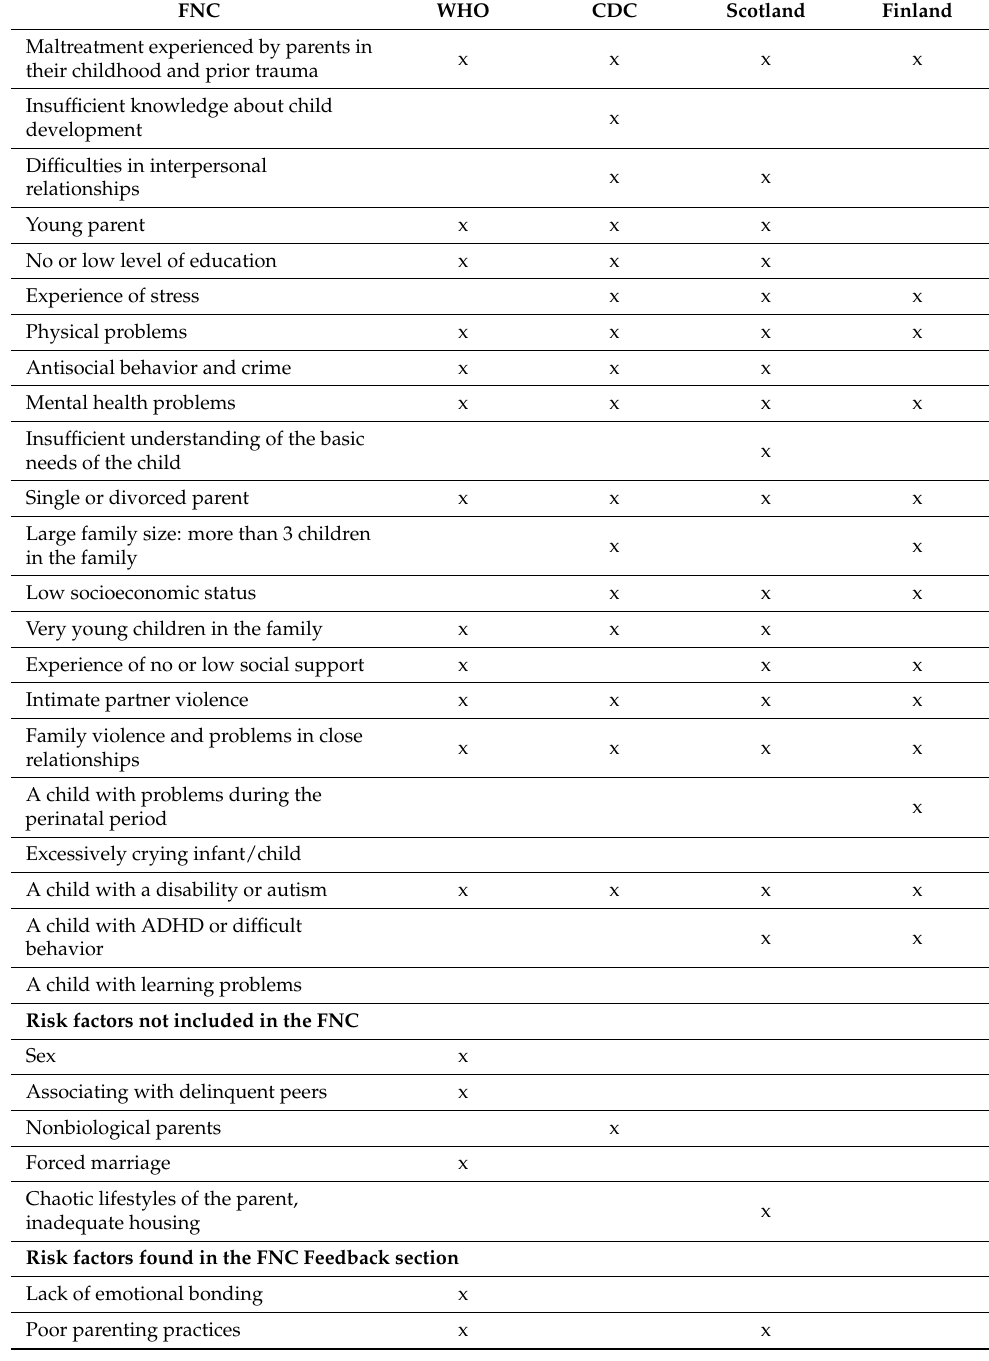
Table 2. Comparison of the FNC family-related risk factors with risk factors identified in the WHO INSPIRE strategy, CDC, Scotland, and Finland. FNC WHO CDC Scotland Finland x x x